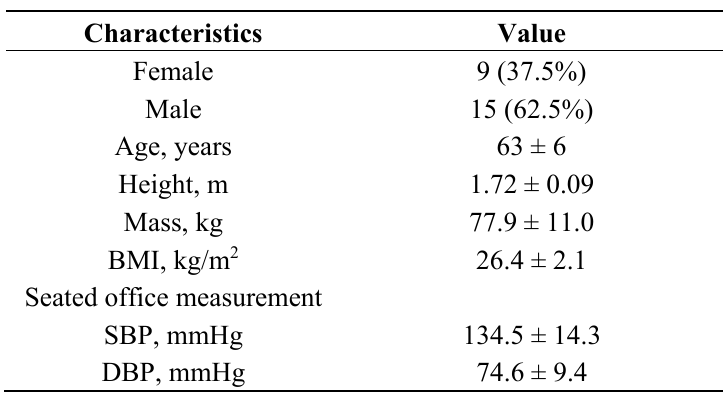
Table 1. Baseline